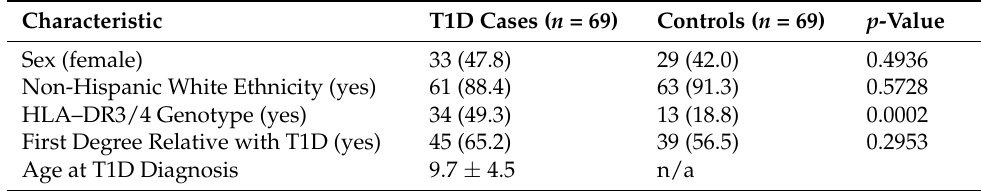
Table 1. Participant characteristics: Type 1 Diabetes (T1D) nested case-control